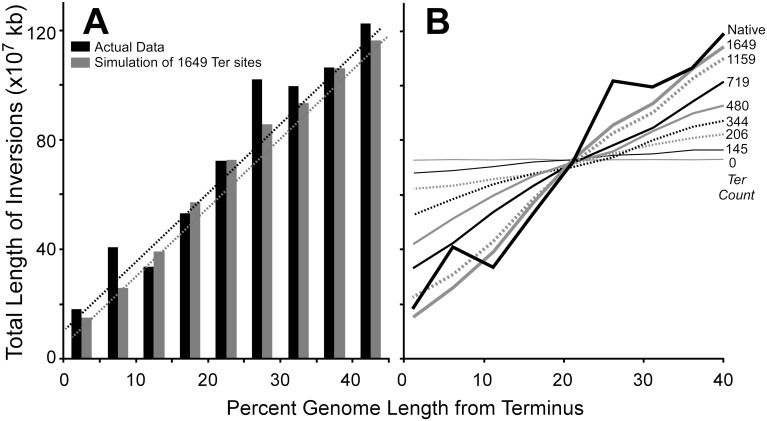
The frequency of Ter sites is insufficient to account for the inversion distribution.A. The distribution of inverted DNA with respect to the replication terminus in 213 genuine genomes (black bars) and simulated genomes (grey bars) with 1649 Ter sites placed in the genome. B. The distribution of inverted DNA in simulated genomes as a function of the number of simulated Ter sites placed in the genome (see Methods). The thick black line represents the distribution of inversions in genuine genomes.